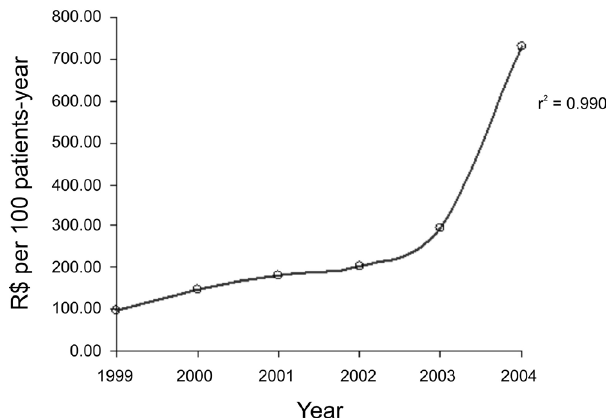
FIGURE 2 – Analysis of total yearly expenditure with the antimicrobial agents studied at HUOP, in the period of 1999 to